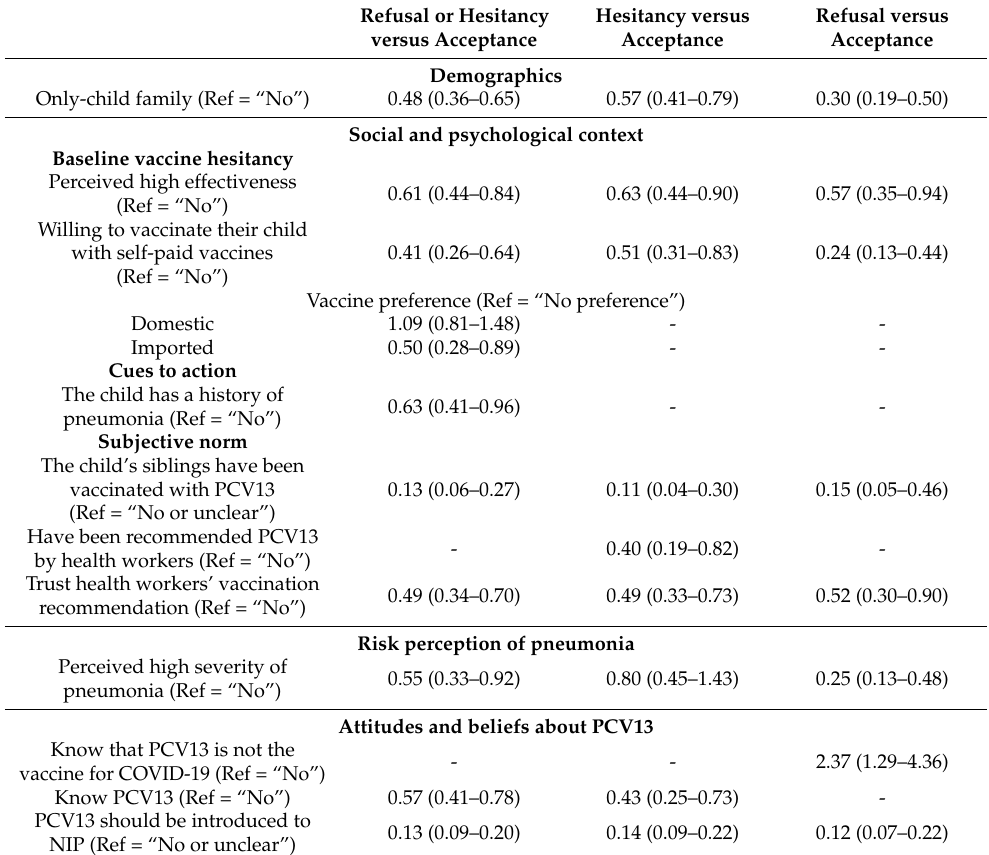
Table 2. Factors associated with caregivers’ vaccine hesitancy or refusal of 13-valent pneumococcal conjugate